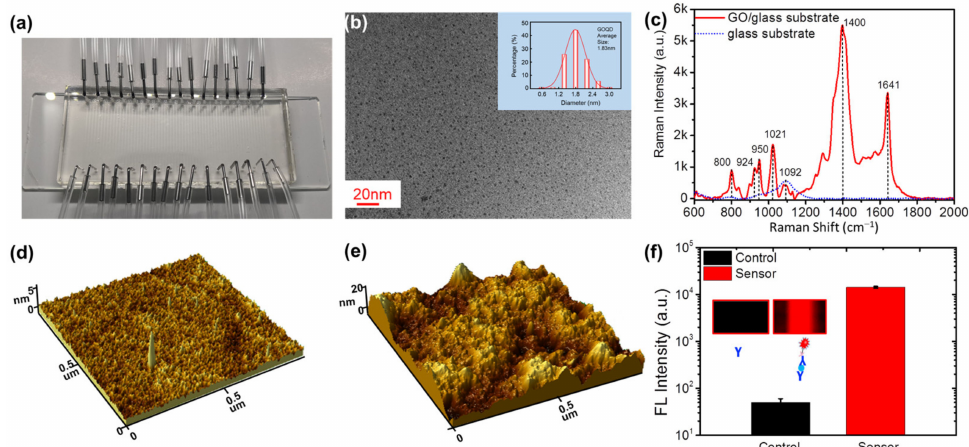
Figure 2. Characterization of the graphene oxide nanoparticle-functionalized fluorescence microflu- idic biosensor. ( a ) Optical photograph of the biosensor. ( b ) TEM image of the GO nanoparti- cles. Inset: Size distribution of GO nanoparticles. ( c ) Raman spectra of the glass substrate and nanographene oxide particle-functionalized substrate. The AFM images of ( d ) the graphene ox- ide nanoparticle-functionalized substrate and ( e ) capture antibody-immobilized substrate. ( f ) The detected fluorescence intensity with nontarget protein and target protein by the graphene oxide nanoparticle-functionalized fluorescence microfluidic